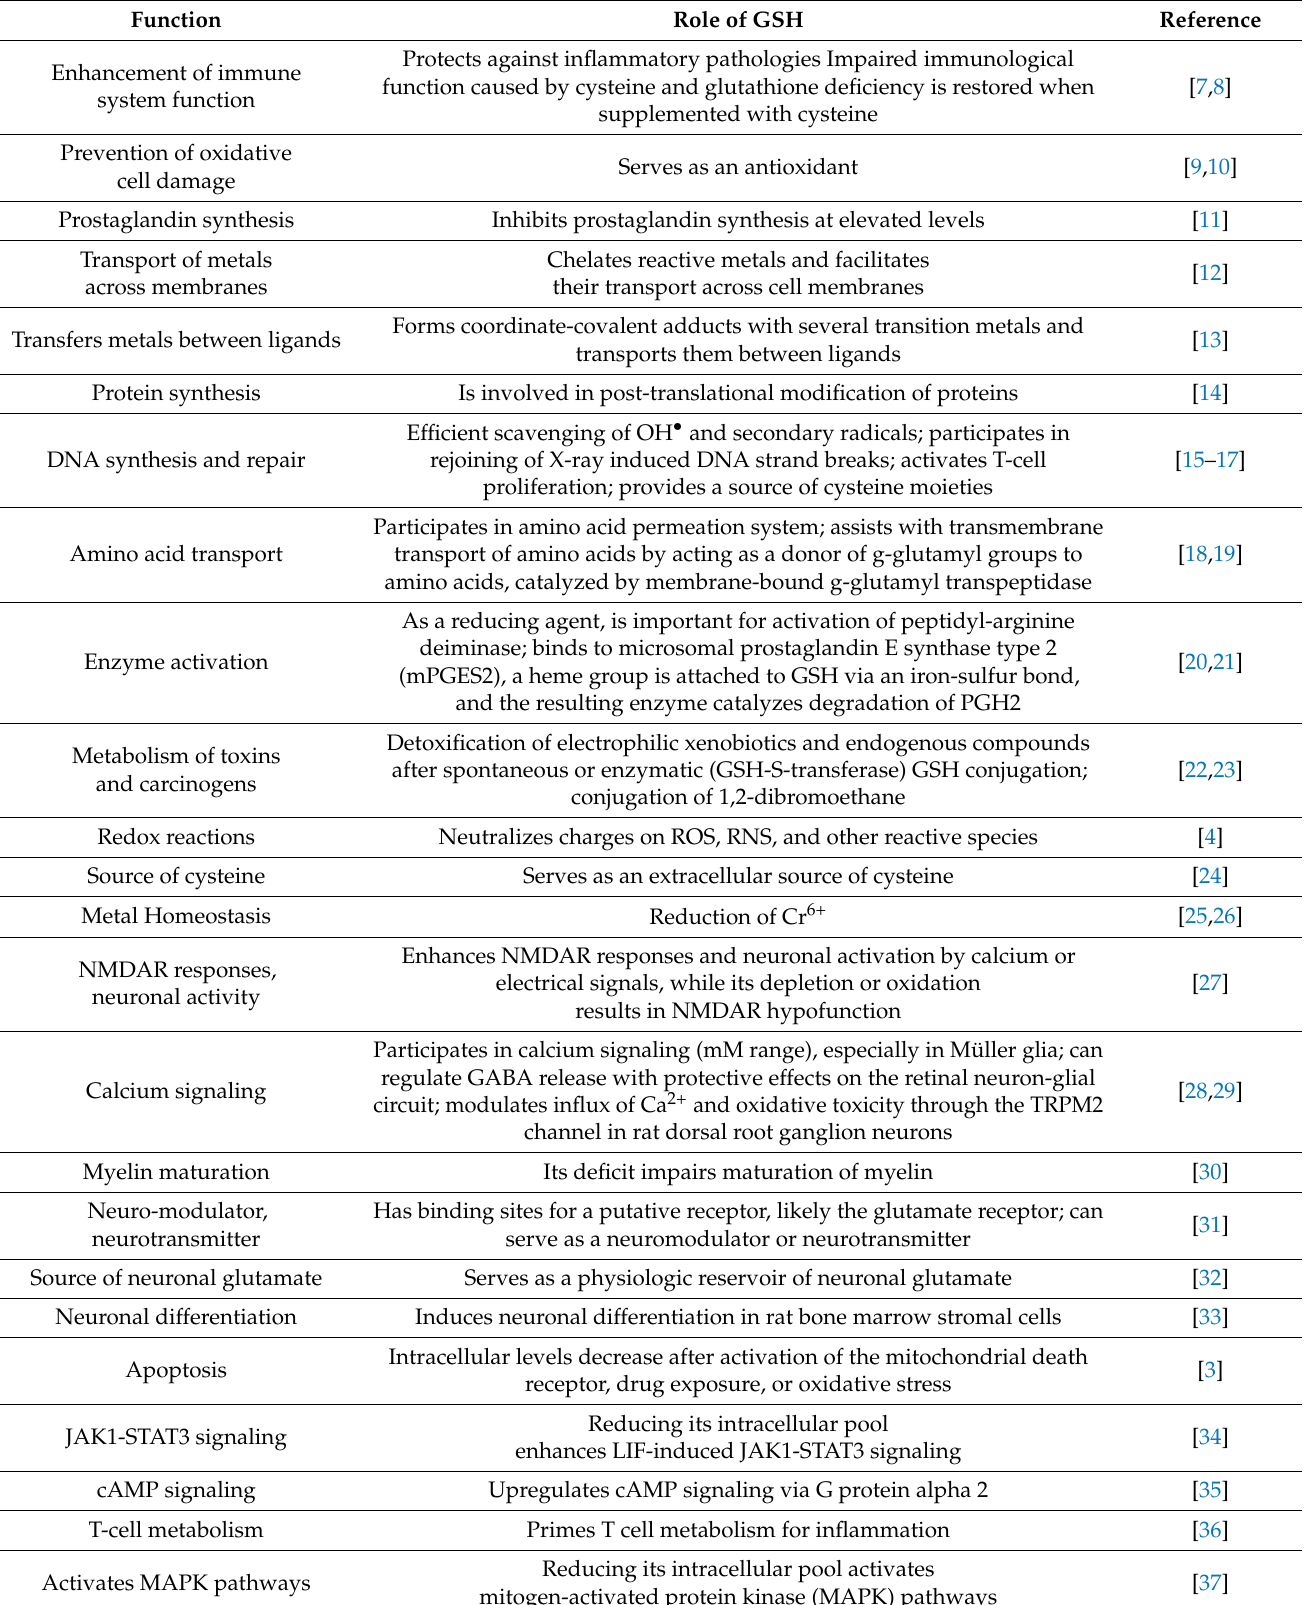
Table 1. Physiological and metabolic functions of